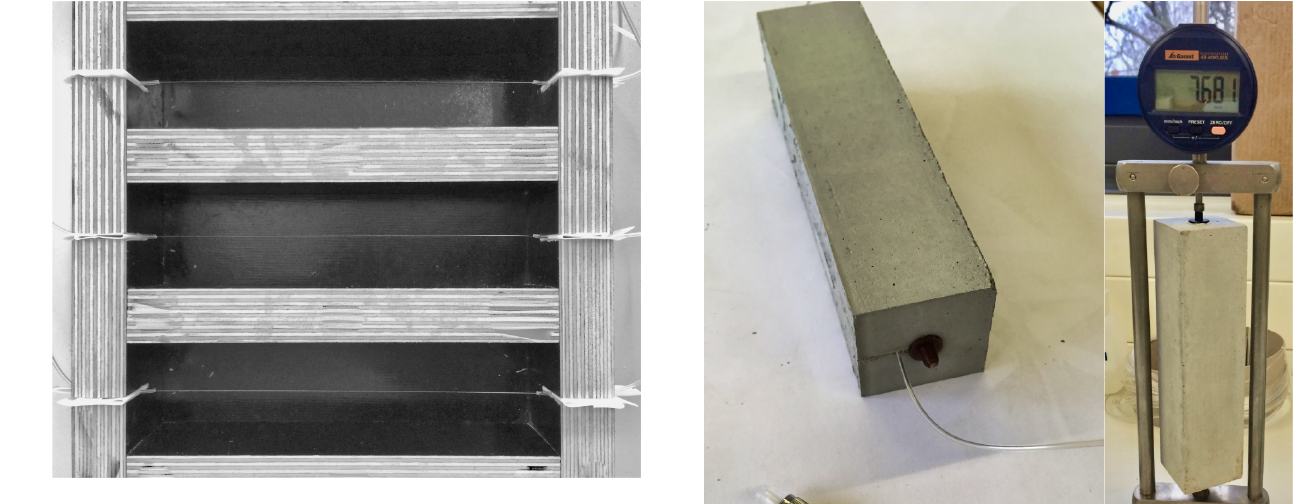
Figure 3. Test specimen formwork with tensioned fiber.